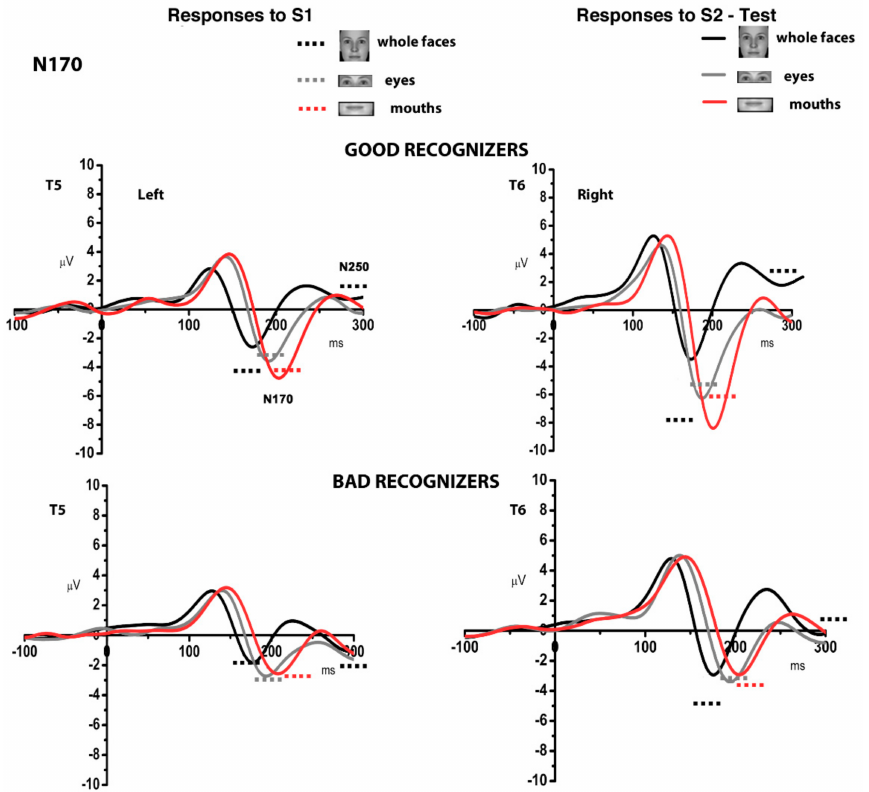
Figure 2. Grand average responses (T5 and T6 electrodes) for good and bad face recognizers for the different categories. The continuous lines represent responses to S2 while the dots represent the mean amplitudes of the N170 and (the N250) for responses to S1.